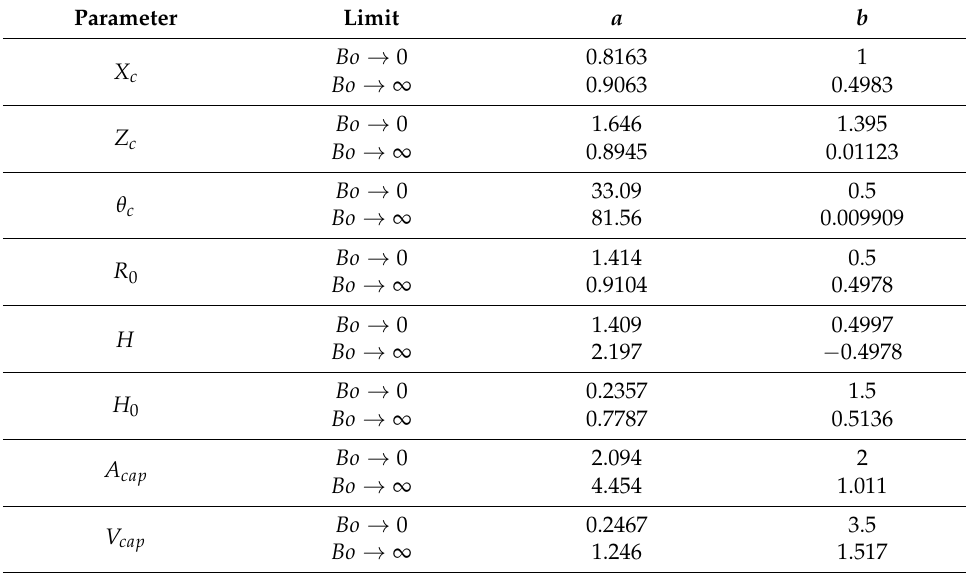
Table 6. Coefficients of the power law for asymptotic